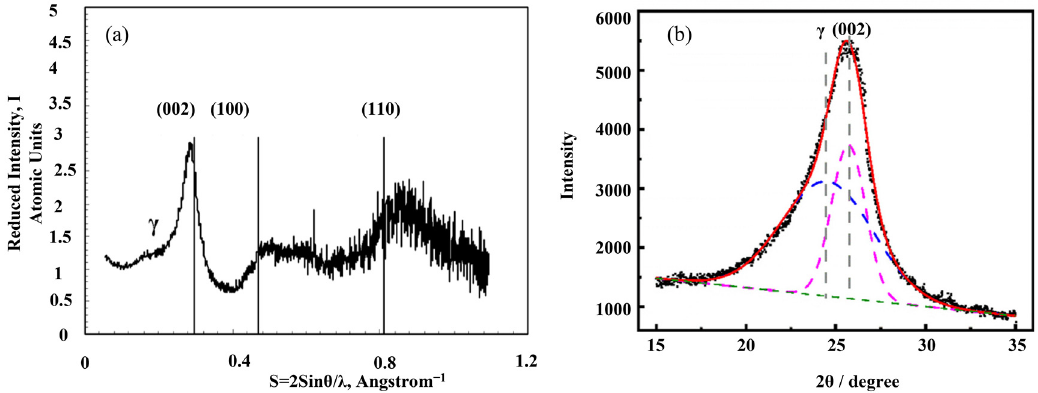
Figure 14. XRD patterns: ( a ) typical XRD pattern of carbon material [83]; ( b ) curve-fitting of XRD pattern of a coke